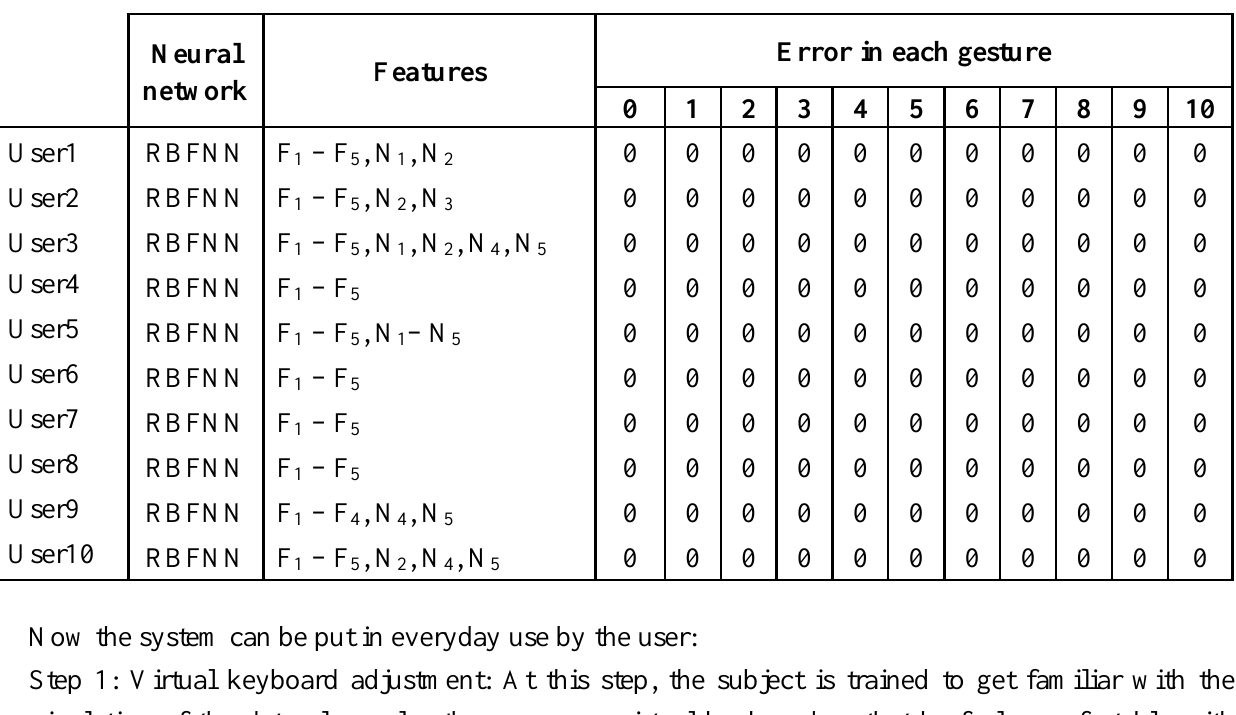
Table 5. Results of stratified tenfold cross